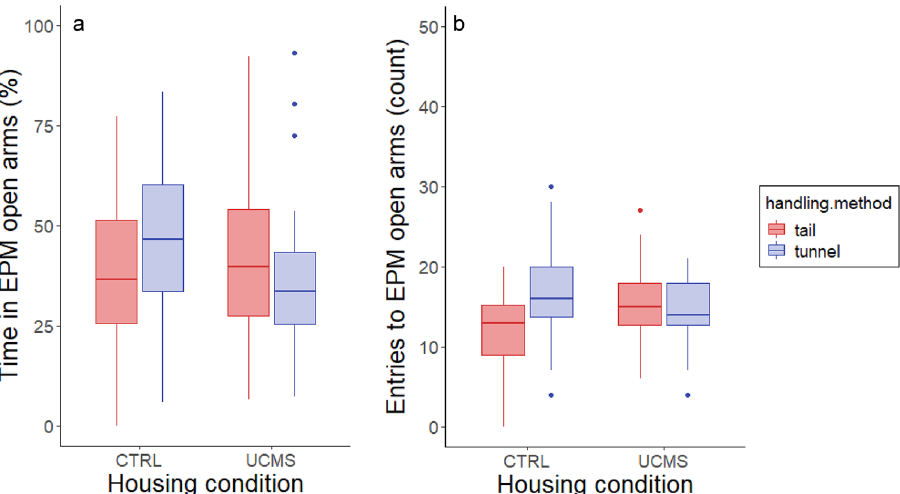
Figure 4. Behaviour on the elevated plus-maze. ( a ) Time spent and ( b ) number of entries to the open arms of the EPM. Handling method affected time spent in open arms and open arm entries of the EPM in CTRL housed